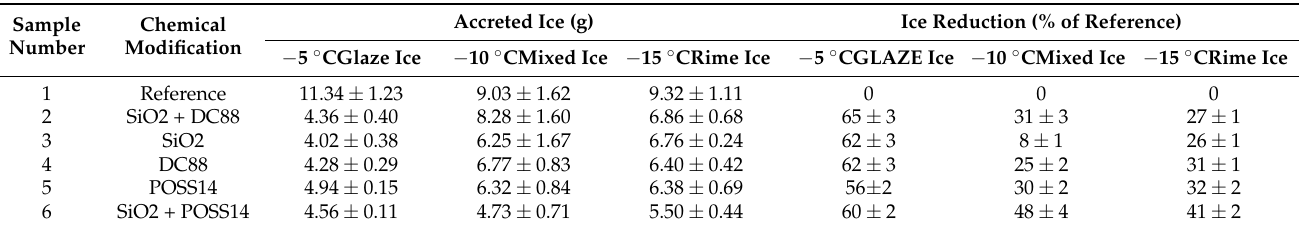
Table 4. Results of ice accretion